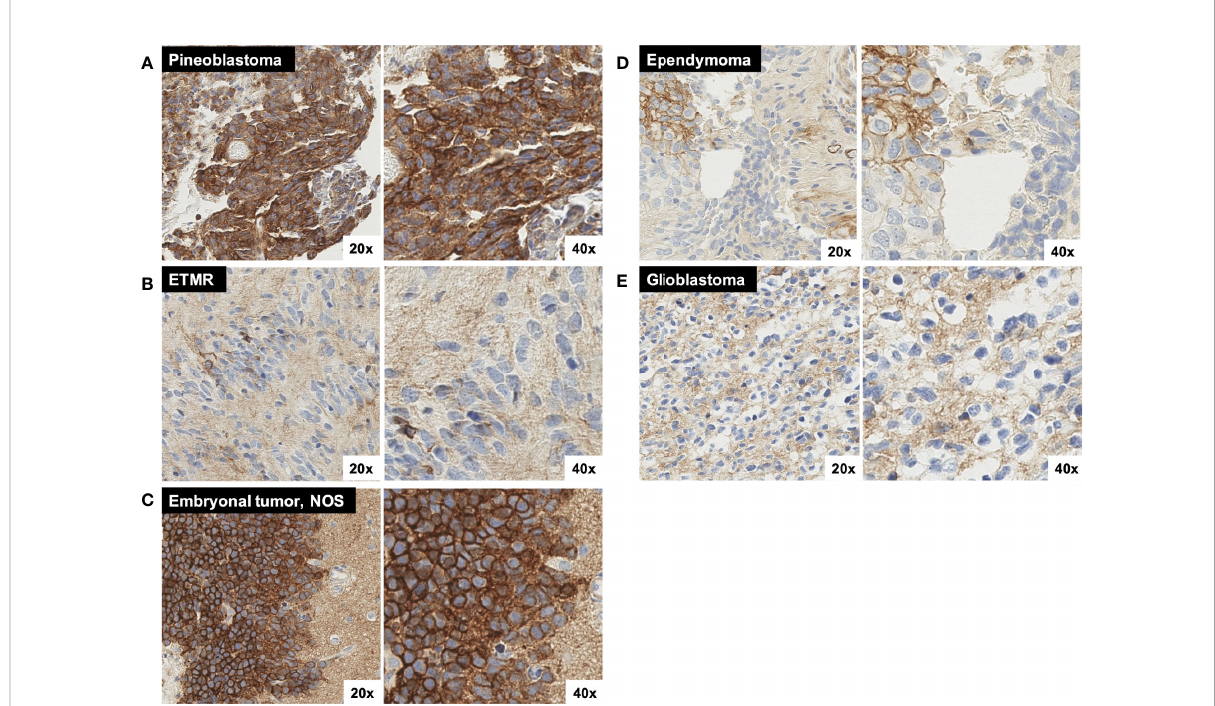
FIGURE 5 Additional representative SST2A IHC images. (A) Pineoblastoma sample with moderate to strong SST2A staining in 10-50% of tumor cells. (B) ETMR sample with very small (<<10%) areas of light and/or incomplete membranous positivity, with otherwise absent tumoral staining throughout. Background granular and/or cytoplasmic staining is demonstrated. (C) Embryonal tumor, NOS with strong SST2A staining intensity in nearly 100% of tumor cells. Tumor cells (left) are shown in proximity to background cortical tissue (right), which demonstrates non-speci fi c (non-membranous) staining. (D) Ependymoma (grade II) sample with very small (<10%), focal areas of membranous positivity (on upper left), but otherwise absent tumoral staining. Background granular and/or cytoplasmic staining is demonstrated. (E) Glioblastoma sample with minimal to absent tumoral membranous staining, yet diffuse background staining of non-neoplastic tissue. All images are shown at 20x and 40x magni fi